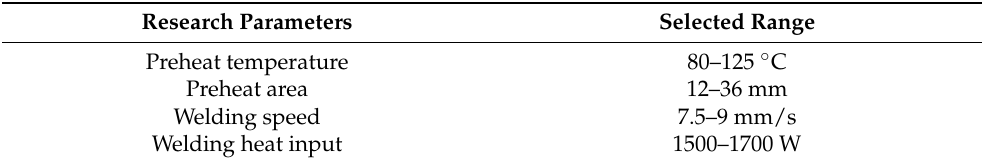
Table 3. The range of research parameters.